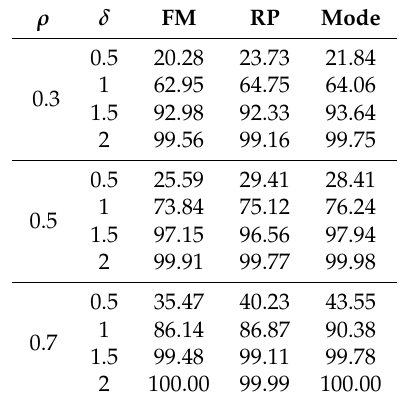
Table 8. Power of the control chart, 1 − β , for the scenarios defined by the M 1 (5) model, assuming dependence between